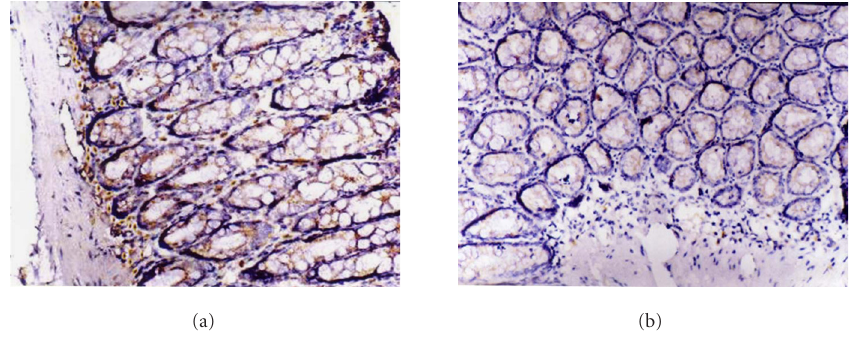
Figure 3. Immunohistochemical staining for ICAM-1 protein expression. SP × 200. Expression of ICAM-1 in (a) the normal group, (b) melatonin group (10mg.kg − 1 ). The ICAM-1 expression was downregulated markedly in melatonin